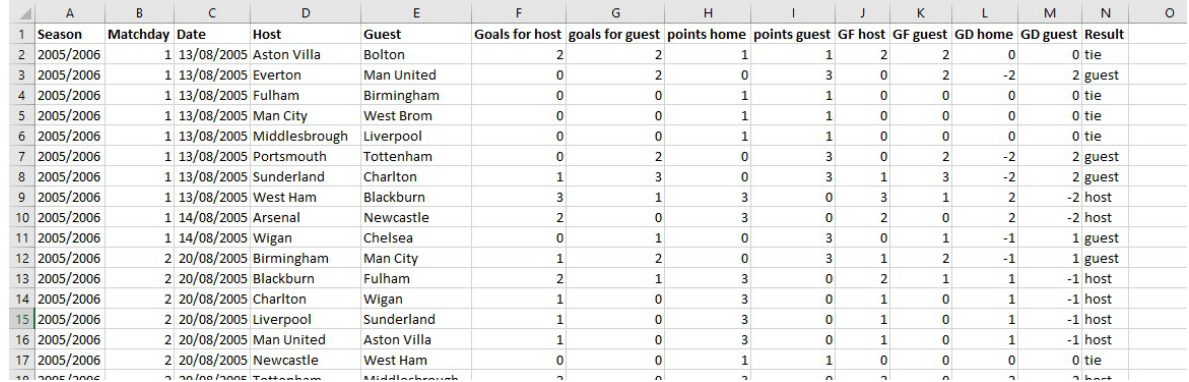
Figure 1. Example of data